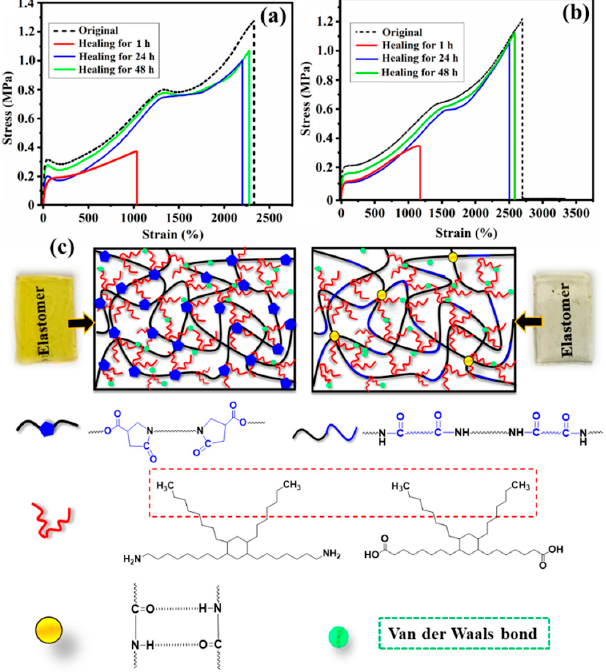
Figure 8. Stress–strain curves of ( a ) PA36,IA, ( b ) PA36,36 PA samples self-healed at room temperature at various times, and ( c ) segment composition of the supramolecular structure of PA elastomers.